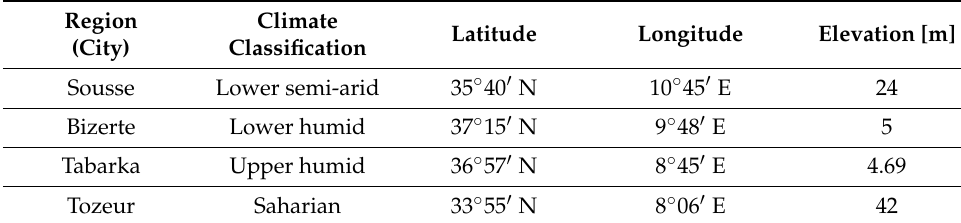
Table 1. Considered cities located in different climatic zones.